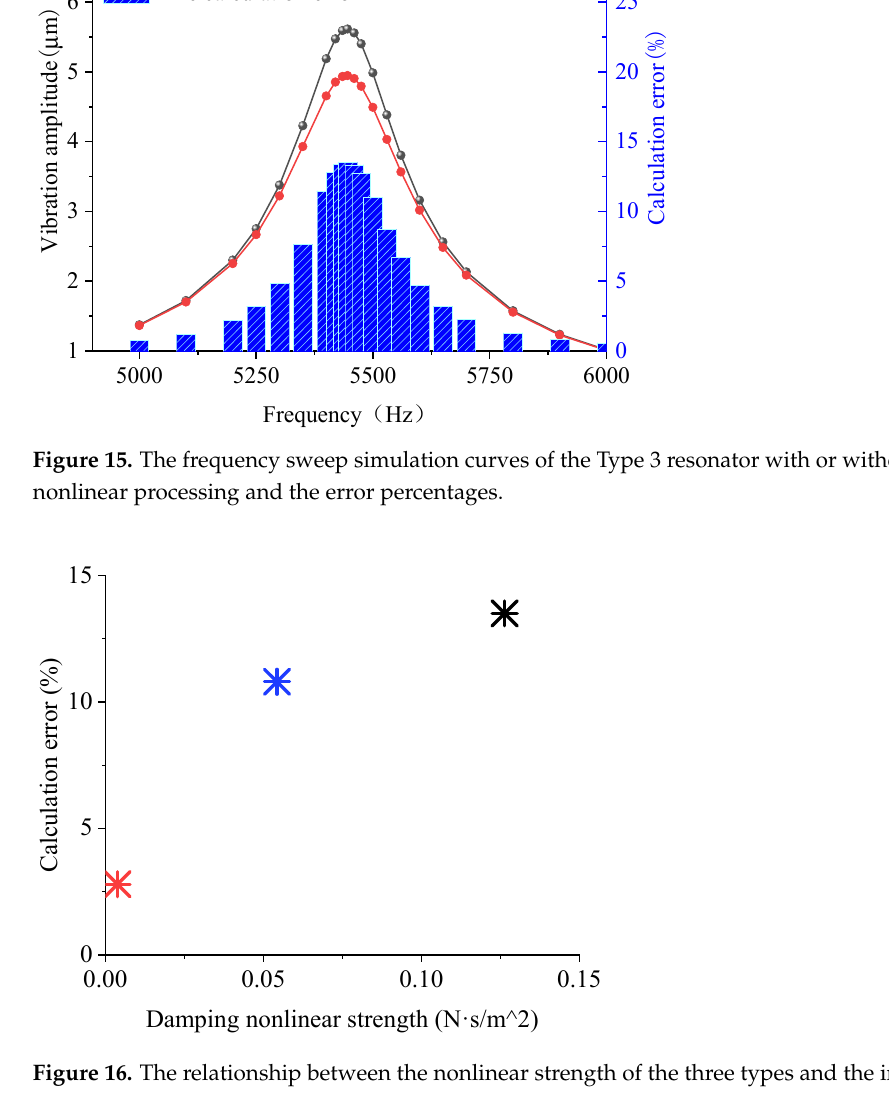
Figure 16. The relationship between the nonlinear strength of the three types and the improvement of simulation accuracy by damping nonlinear processing. The red, blue and black * denote Type 1, 2 and 3, respectively.